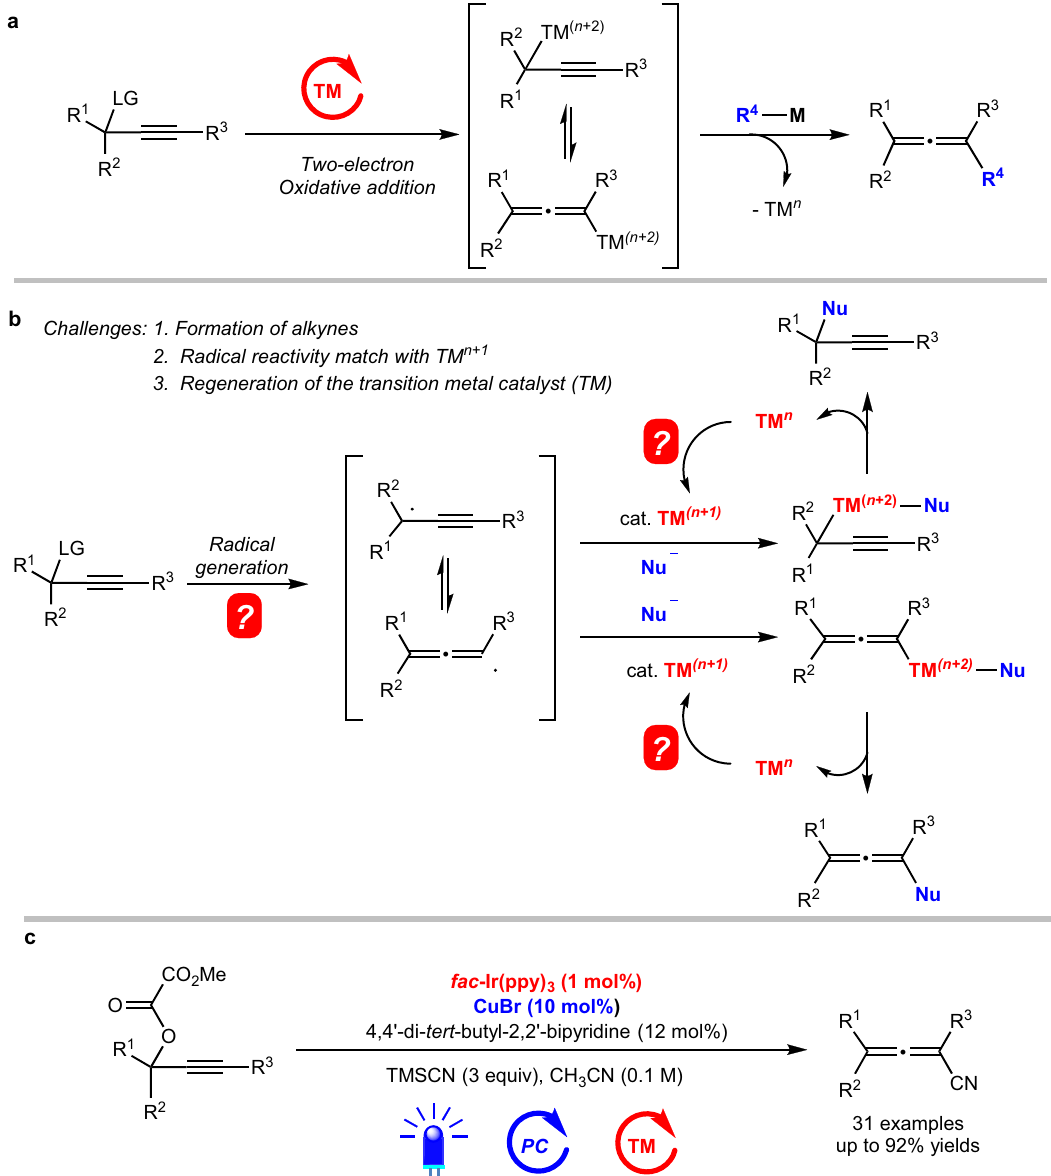
Fig. 1 Coupling reactions involving propargylic derivatives. a Traditional transition metal-catalyzed two-electron cross-coupling reactions. b A concept of one-electron process for cross-coupling reactions. c This work: an example of such a concept for allenenitrile synthesis (visible light/transition metal dual